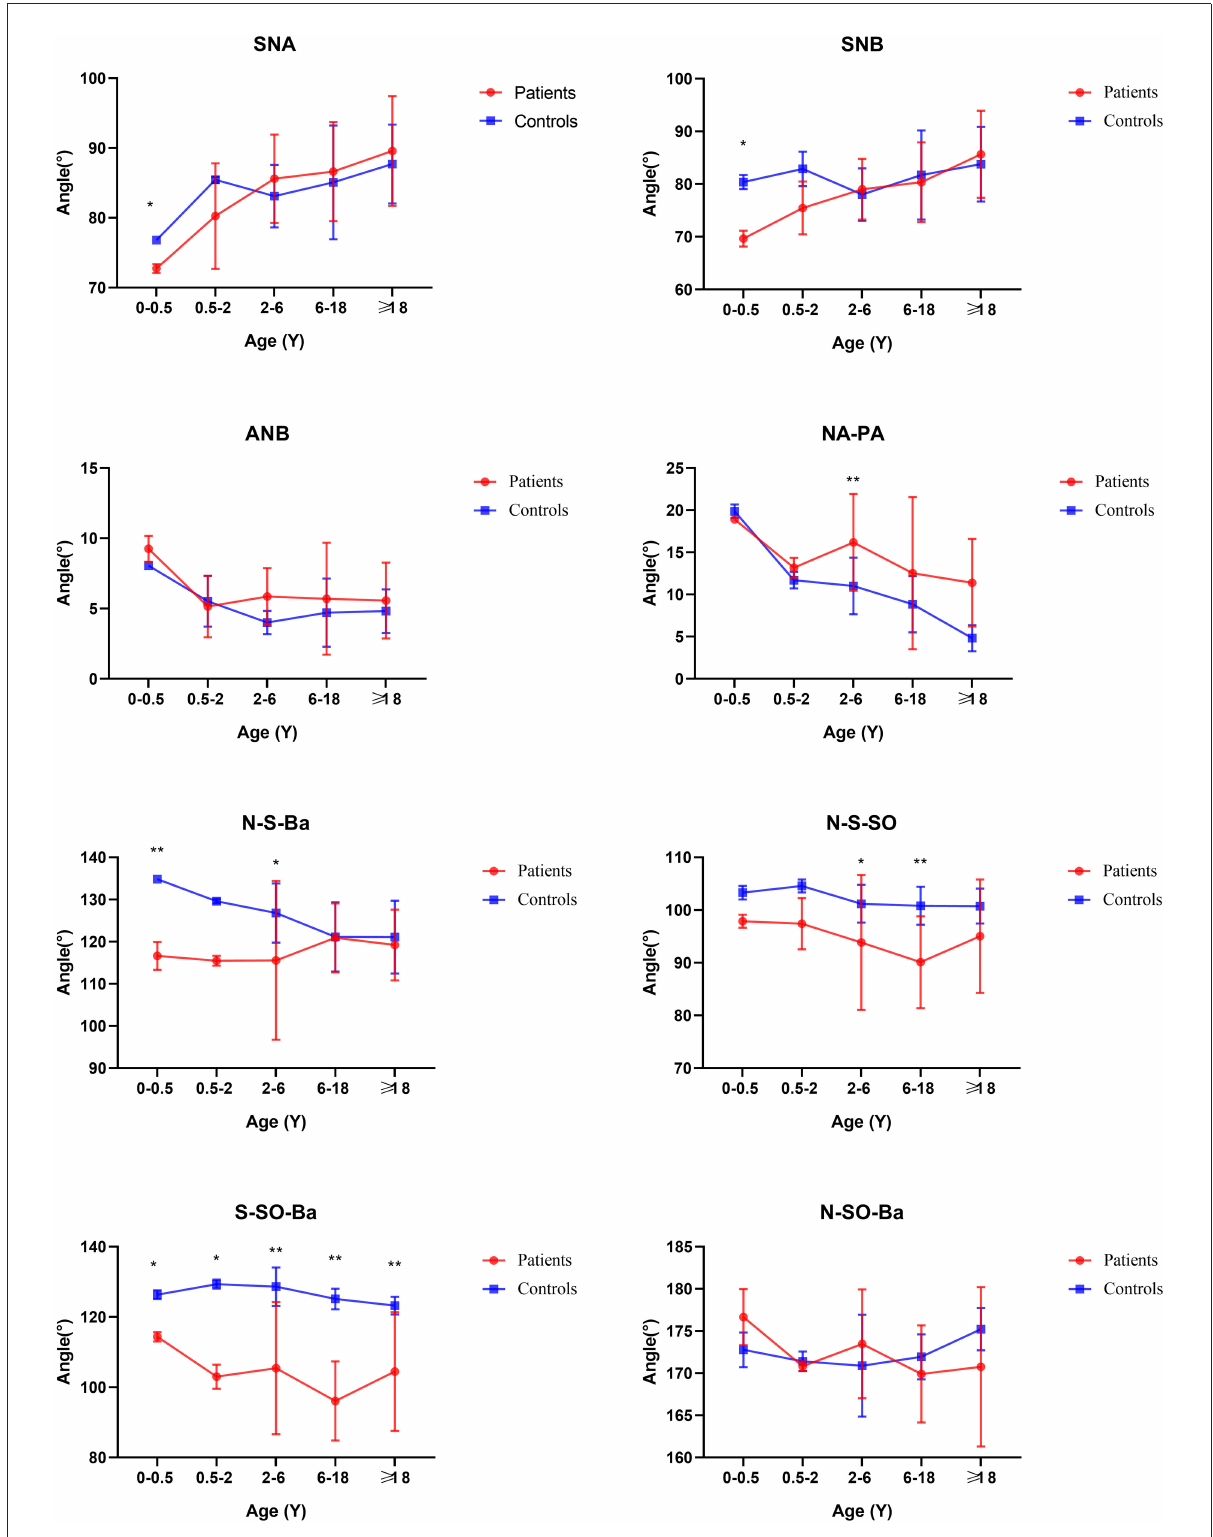
FIGURE6 Cranial base external linear measurements by subgroup analysis. * P < 0.05; ** P <